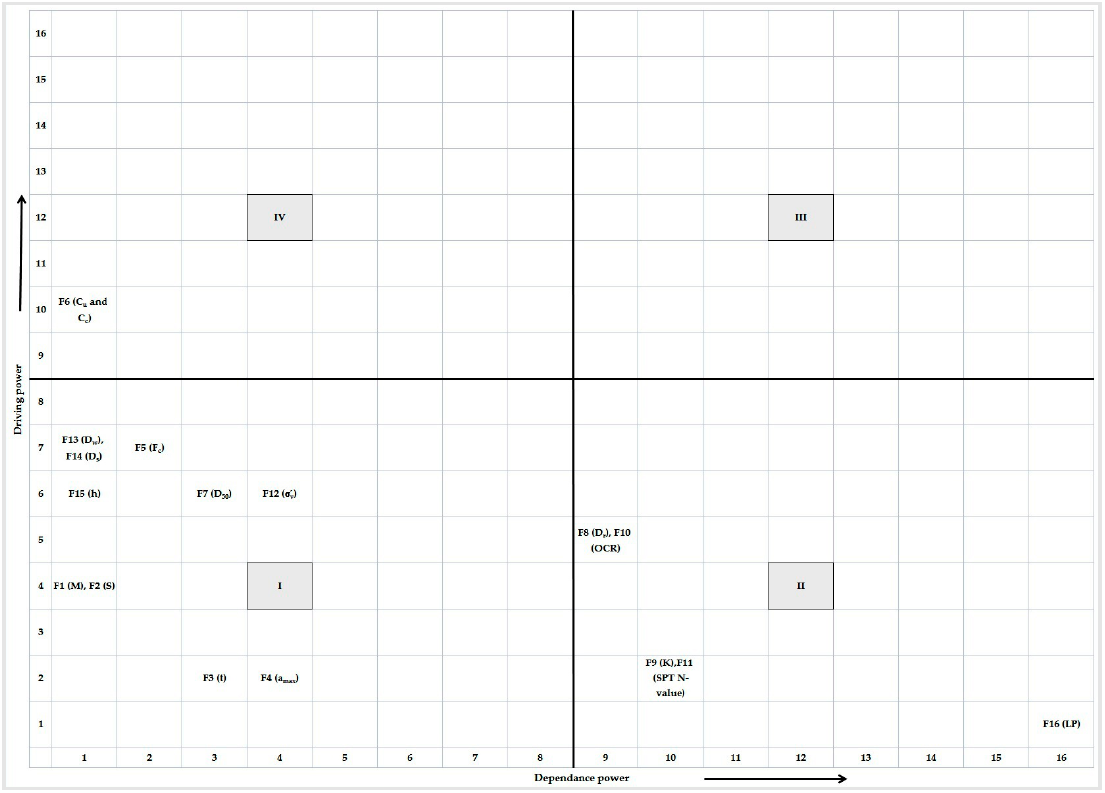
Figure 5. Cross-impact matrix multiplication applied to classification (MICMAC) analysis of soil liquefaction factors.